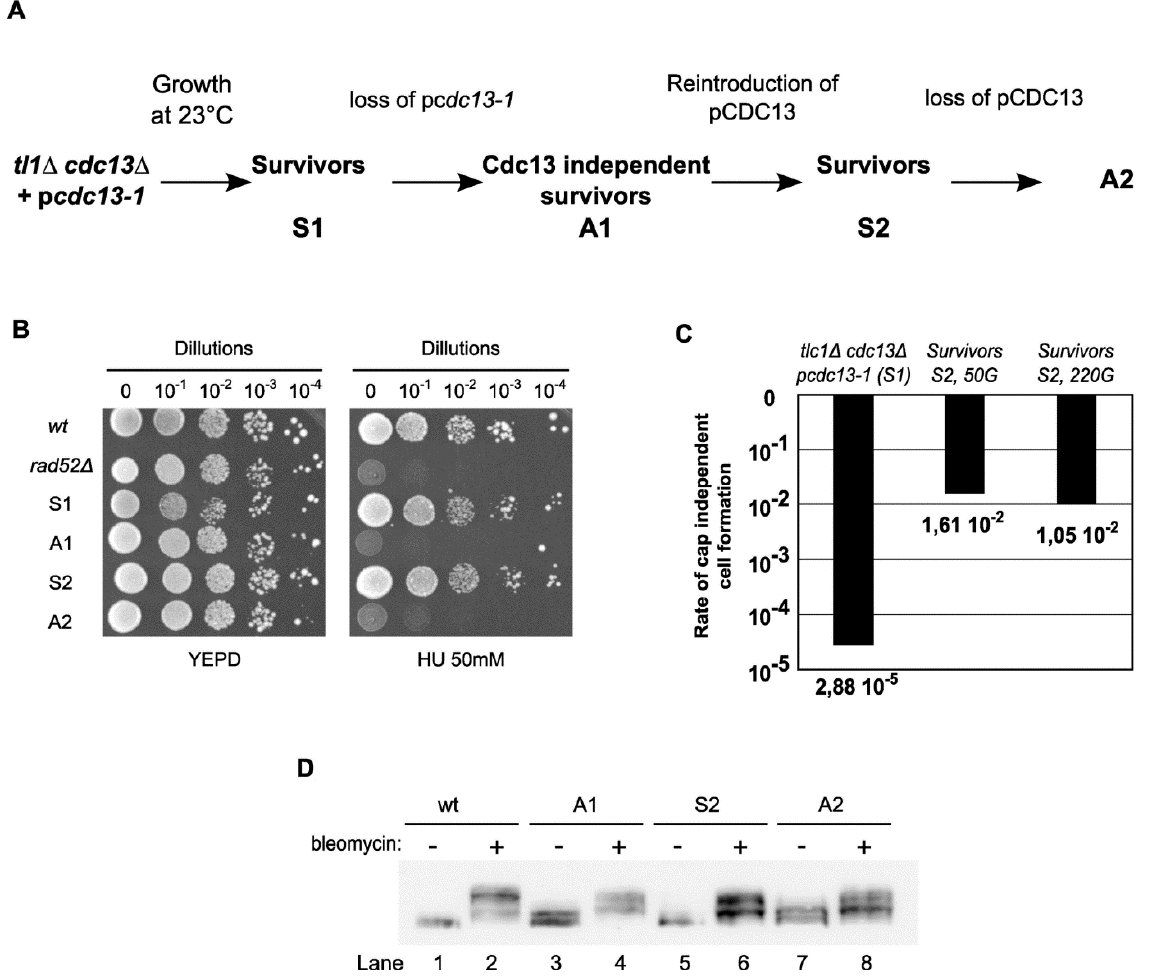
FIGURE 5: The process of generating Cdc13 -independent survivors ( cdc13 Δ-cells) comprises a reversible component. (A) Schematic repre- sentation of the procedure used to generate S2 survivors and second generation cdc13 Δ-A2 of Cdc13-independent survivors. S1 survivors and cdc13 Δ-A1 were generated as described in Fig. 1. S2 survivor cells were derived from cdc13 Δ-A1. These cells were grown for up to 220 generations (220G) after transformation with the plasmid carrying the cdc13-1 allele. For cdc13 Δ-A2 cells (MLY123), the loss of the p CDC13 plasmid was verified by growing cells on FOA synthetic medium. (B) Cells identified with symbols as in (A) were spotted onto YEPD plates with or without hydroxyurea (HU) and incubated for 72 h at 23°C. A haploid rad52 Δ strain was used as control for HU sensitivity. (C) Rate of successful cdc13 -independent cell formation (calculated by fluctuation test) for survivors S1 (MLY112) and survivors S2 (MLY122 + pcdc13-1). S2 survivors were grown for 50 or 220 generations after p cdc13-1 introduction and before the fluctuation test for plasmid loss was per- formed. (D) Western blot of whole cell protein extracts prepared from strains indicated with the same symbols as in (A)(top). Cell treatment with bleomycin is indicated with – and +, and the blot was probed with an anti-Rad52 antibody as in Fig.